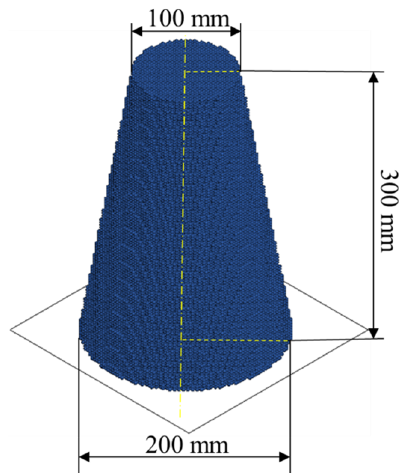
Figure A1. The numerical model of the slump test.